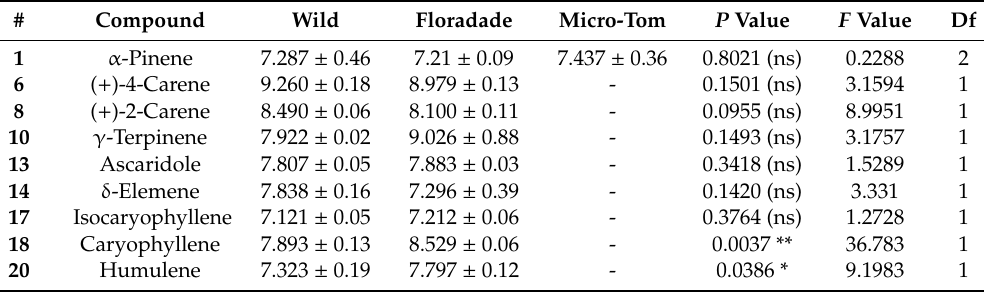
Figure 2. Plant volatiles from healthy plants of three varieties of tomato. Compounds were presented in profile and were obtained from three varieties for one bioassay in healthy tomato plants (psyllid-free). Floradade (white bars), wild (black bars), and Micro-Tom (gray bars). Compounds with > 90% of quality were selected: α -pinene ( 1 ), o-cymene ( 2 ), 1,3,5-Cycloheptatriene, 3,7,7-trimethyl- ( 3 ), l - β -pinene ( 4 ), ( + )-4-carene ( 6 ), ( + )-2-carene ( 8 ), γ -terpinene ( 10 ), α -terpinolene ( 12 ), ascaridole ( 13 ), δ -elemene ( 14 ), copaene ( 15 ), isocaryophyllene ( 17 ), caryophyllene ( 18 ), humulene ( 20 ), and hexadecane ( 21 ). Values are means ± SE, n = 3. Table 2. Statistical analyses for the compounds that were shared in the headspace of healthy plants among, at least, two out of three varieties (those compounds with > 90% of quality were selected). Values indicate non detected means ( ± SD; n = 3). P values indicate significant di ff erences in compounds levels among the wild, Floradade and Micro-Tom varieties. ns, non-significant. Level of significance: *, P = 0.05; **, P = 0.01. #, number of compound assigned (see Table 1). (Univariate ANOVA, non-parametric Kruskal-Wallis test at P = <